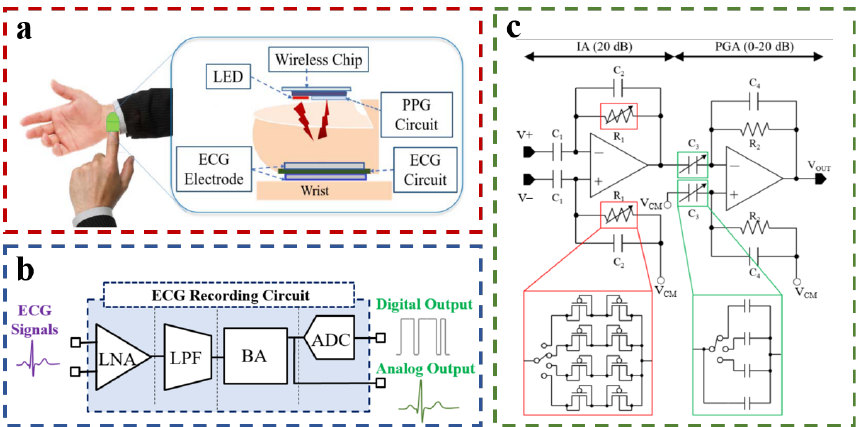
Figure 11. ( a ) Conceptual drawing of equipment; ( b ) Block diagram of the ECG circuit; ( c ) Schematic diagram of LNA. Reproduced with the permission of [31]. Copyright 2018,